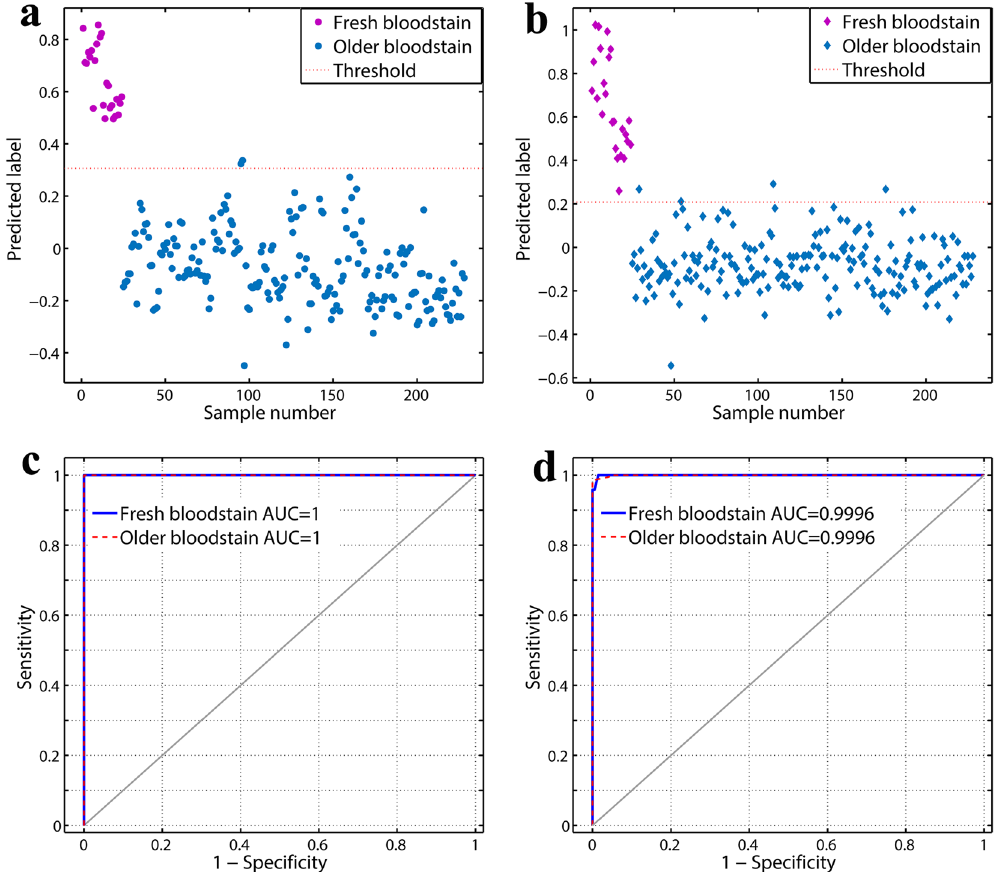
Figure 4. ( a ) Prediction scores of the indoor training dataset using the indoor PLS-DA model. ( b ) Prediction scores of the outdoor training dataset using the outdoor PLS-DA model. The red dotted line represents the default classification threshold. ROC curves with AUC for fresh and older bloodstain classes in the ( c ) indoor and ( d ) outdoor PLS-DA classification models. Random choice is denoted by the grey diagonal line.